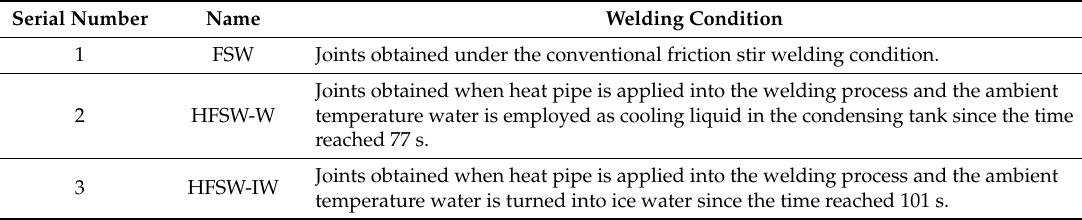
Table 2. Denotation of samples under di ff erent welding